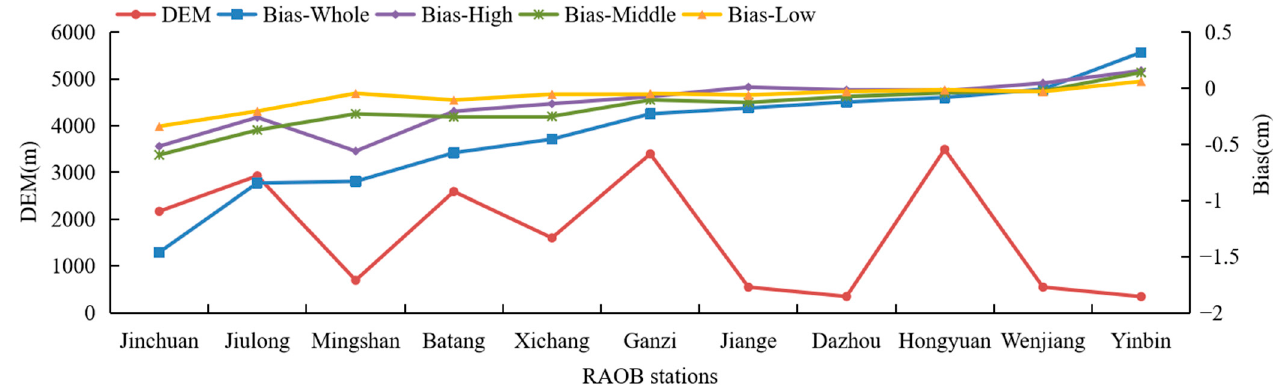
Figure 6. Statistics of the Bias and DEM from each RAOB station.